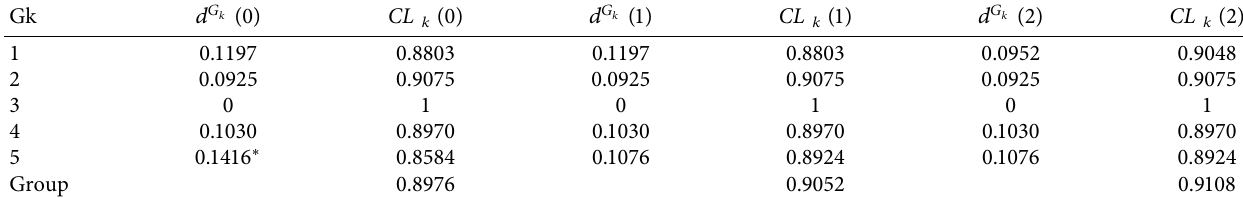
Table 13: .e adjustment process without considering the interactive weights.